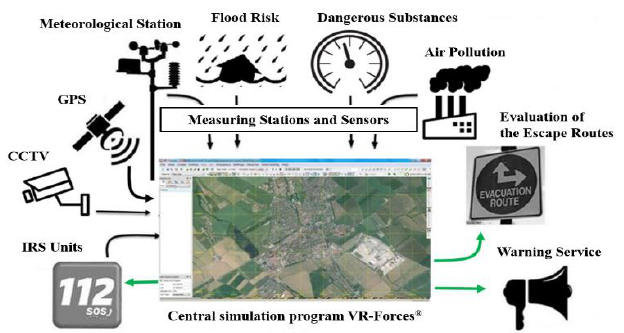
Figure 3. Draft of informational sources for